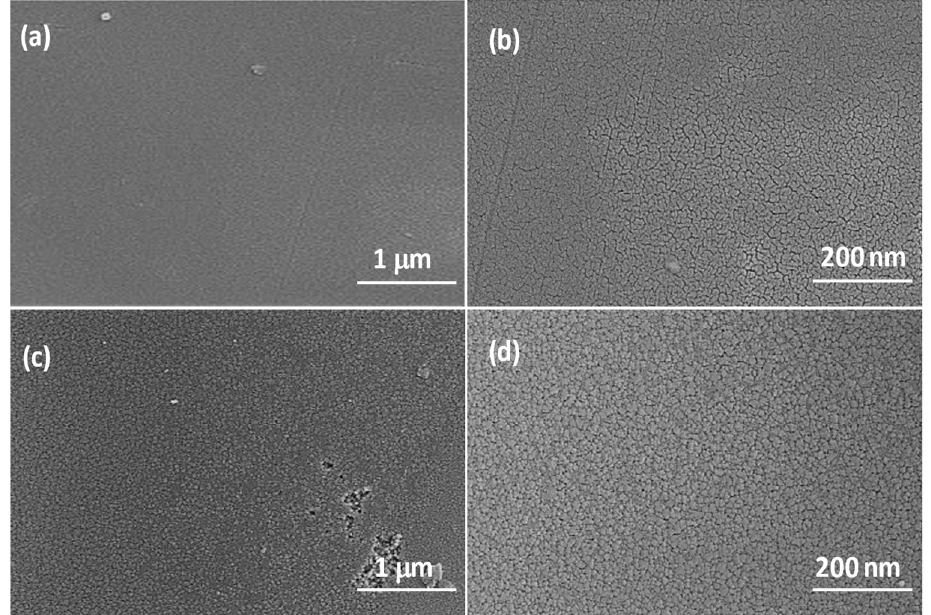
Figure 3. SEM micrographs of ( a , b ) WO 3 and ( c , d ) Zn: WO 3 films.